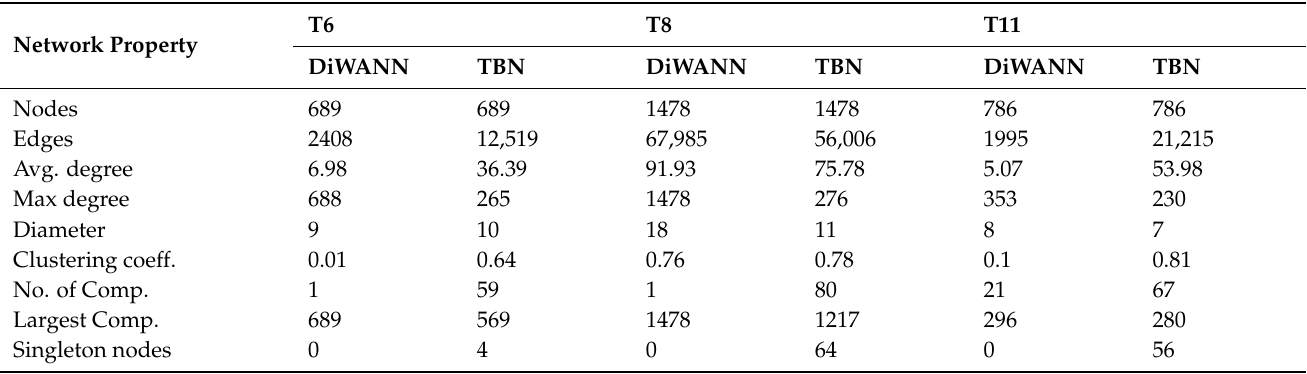
Figure 8. Threshold based networks showing the Delta variant for three time periods. ( a ) The network for T6 comprised of 689 nodes, ( b ) T8 comprised of 1479 nodes, and ( c ) T11 comprised of 786 nodes. The shape of the nodes corresponds the variant and the node color to the location as depicted by the legend. Nodes labelled as ‘USA’ did not have location information. The inverted triangular nodes have characteristic Delta variant mutations whereas the circular nodes might have other mutations in the established D614G variant. Table 3. Network properties of DiWANN and threshold-based networks (TBN) for periods T6, T8 and T11.